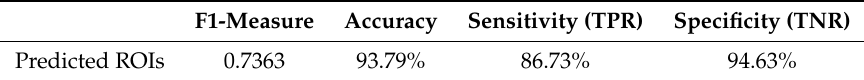
Table 2. Metrics of averaged results of the comparison between manually and automatically segmented images of the